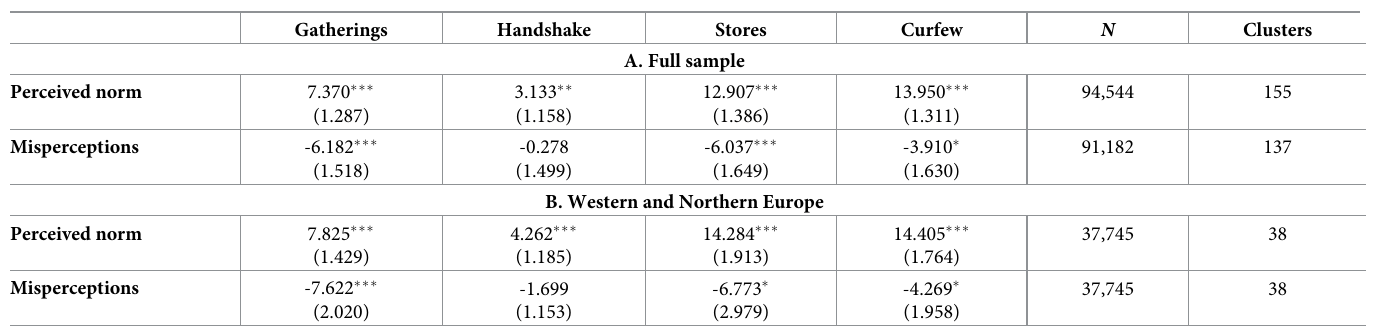
Table 1. DiD estimates of the effect of the UK lockdown.